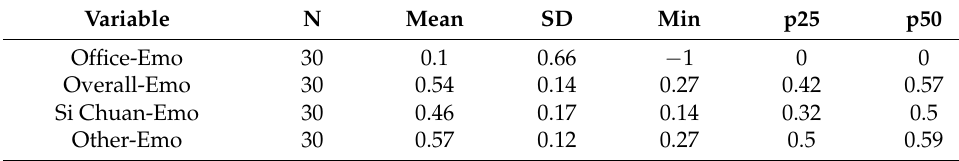
Table 3. Descriptive statistics.